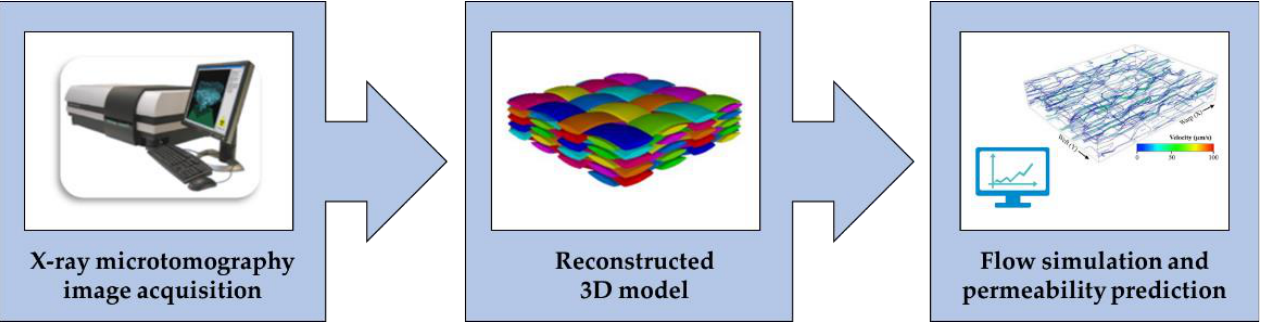
Figure 11. Illustration of the procedure for permeability prediction using models generated from 3D X-ray microtomography images (adapted from Yousaf et al. [107] and Ali et al. [108]). After tomographic image acquisition by micro-CT, a 3D model can be